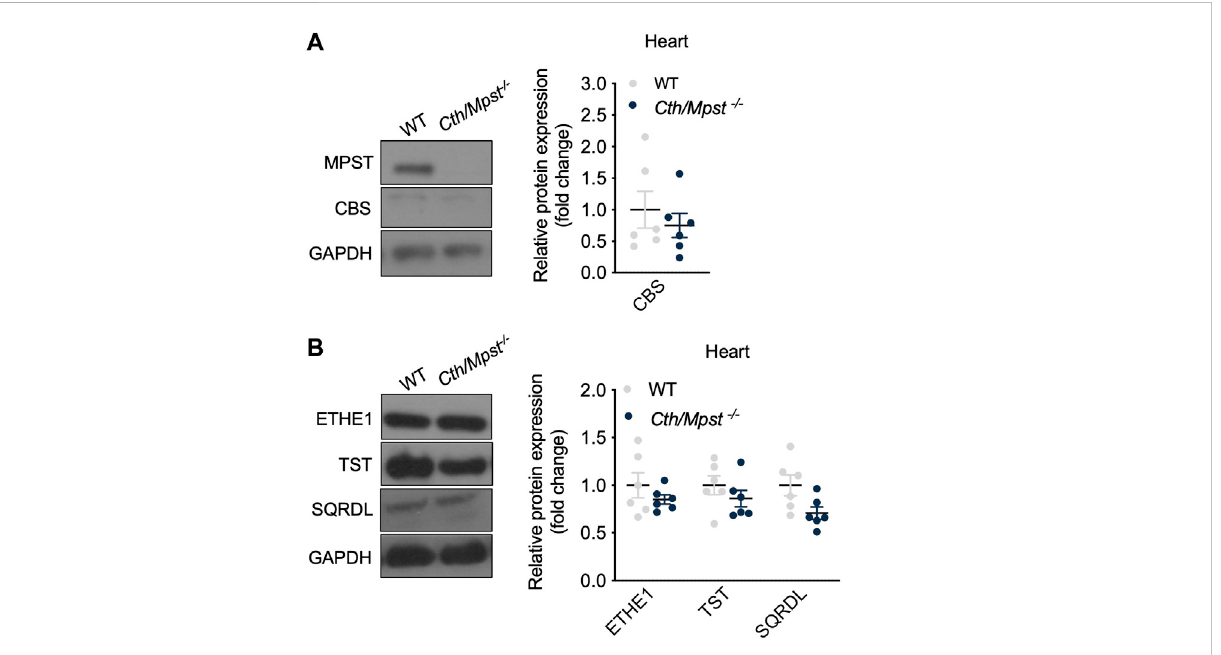
FIGURE 2 Cth/Mpst double deletion does not affect the expression of CBS and sul fi de-metabolism enzymes in heart. WT and Cth/Mpst − / − mice were sacri fi cied, proteins wereextracted from hearttissues and enzymes leves were determined by western blot. Representative western blots and quanti fi cation of (A) MPST, CTH, CBS and (B) ETHE1, TST, SQRDL levels in heart. Protein expression is presented as ratio over WT group. Data were normalized to GAPDH and presented as means ± S.E.M. N = 6 mice per group.